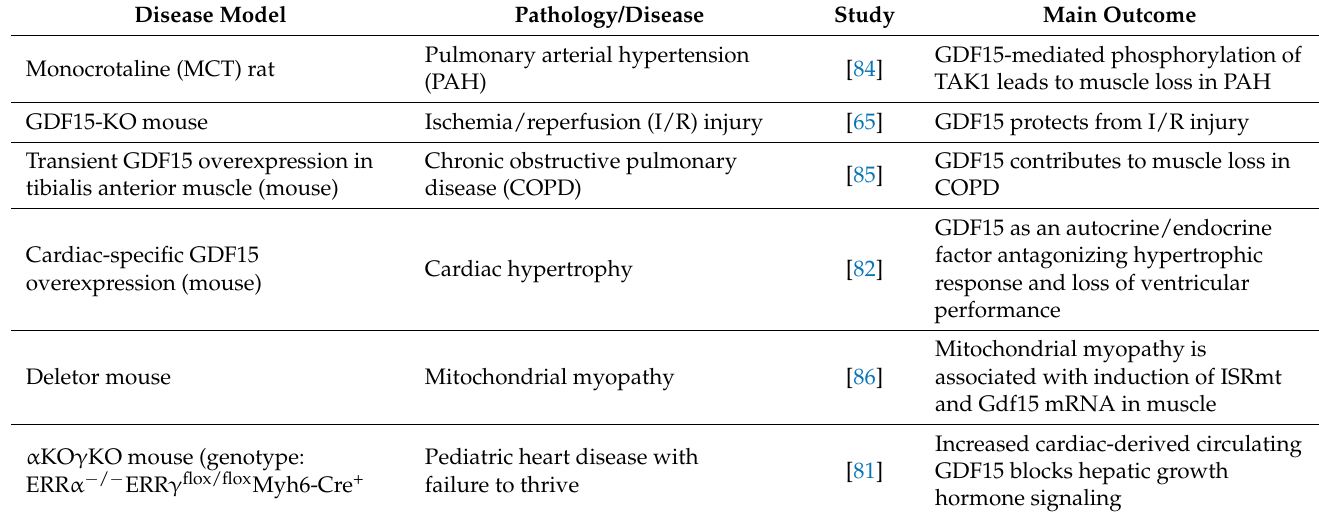
Table 1. Animal models implicating GDF15 as a